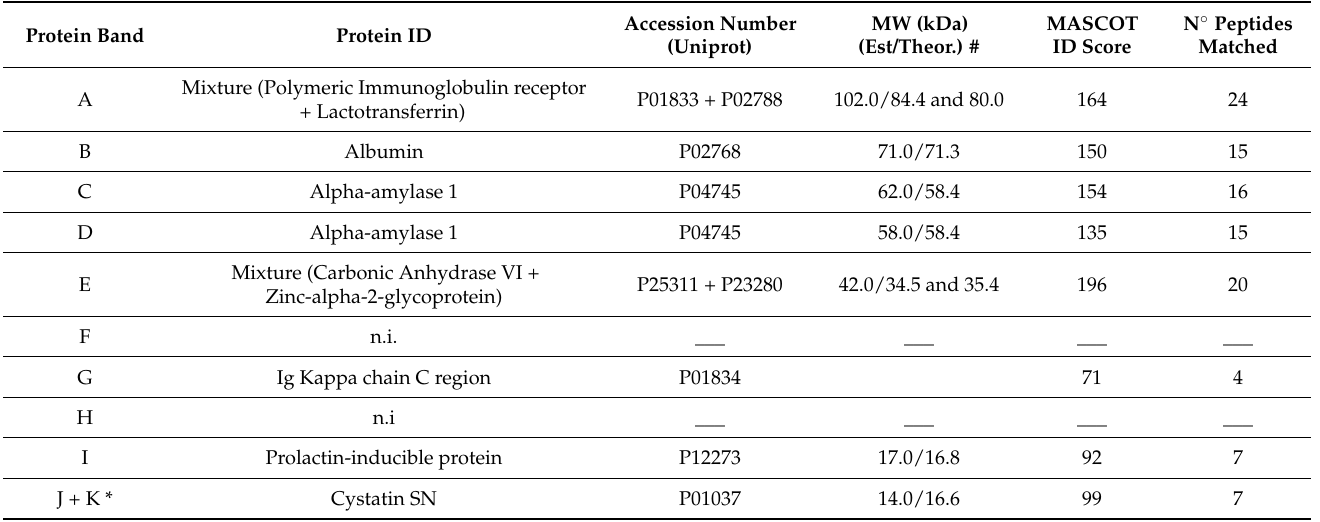
Table 2. Mass spectrometry identification of salivary proteins present in the SDS-PAGE